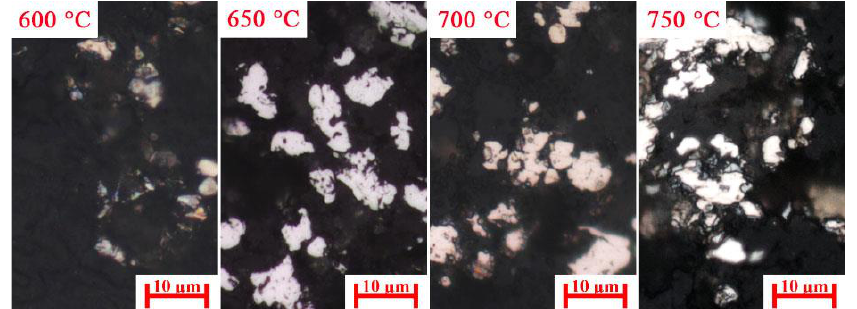
Figure 9. Microstructures of carburized pellets at different carburization temperatures (iron carbide: white).